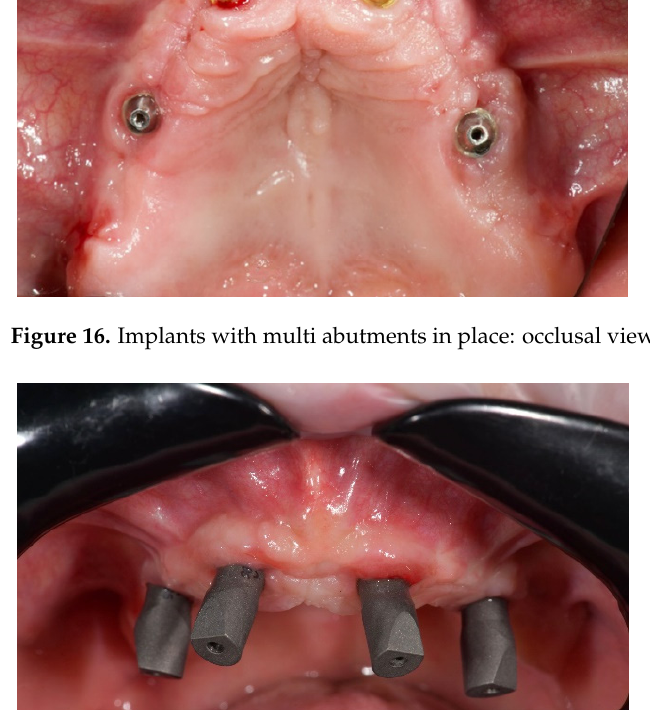
Figure 18. From left to tight: digital impression of the temporary restoration; matching between the two digital impressions; digital impression of the scan abutments in place.